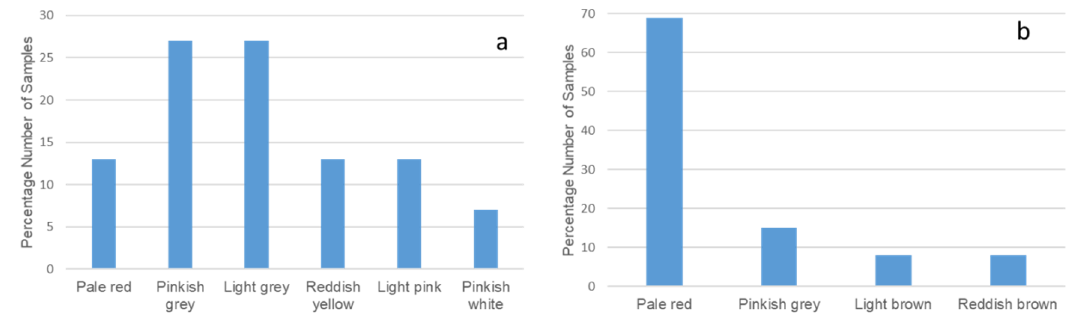
Figure 3. Colour distribution of the studied kaolins: ( a ) Cretaceous and ( b ) Paleogene/Neogene.